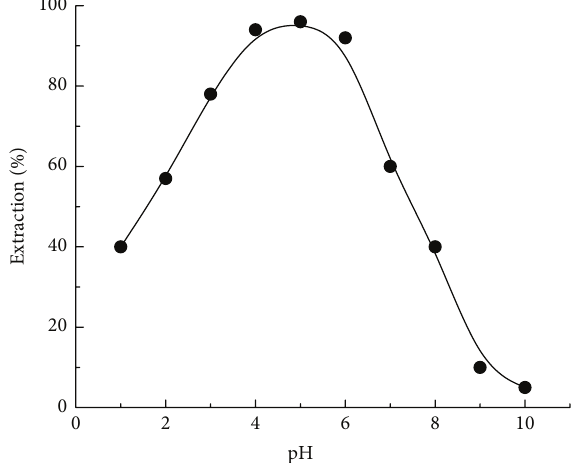
Figure 3: Effect of pH on the extraction of TEAC-Th(IV) complexes at 525 nm with chloroform